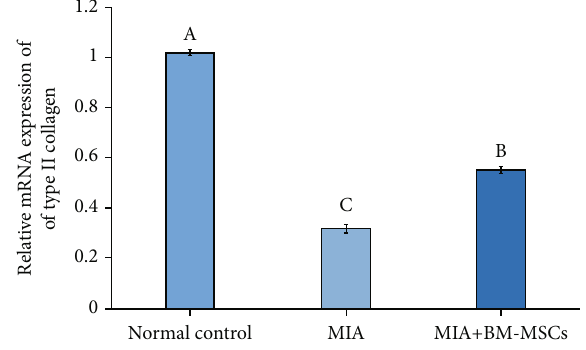
MIA+BM-MSCs Figure 6: E ff ect of BM-MSC treatment ( 5 × 10 6 cells/rat) on the mRNA expression level of type II collagen in MIA-induced osteoarthritic animals. Means, which have di ff erent symbols, are signi fi cantly di ff erent at P < 0 : 05